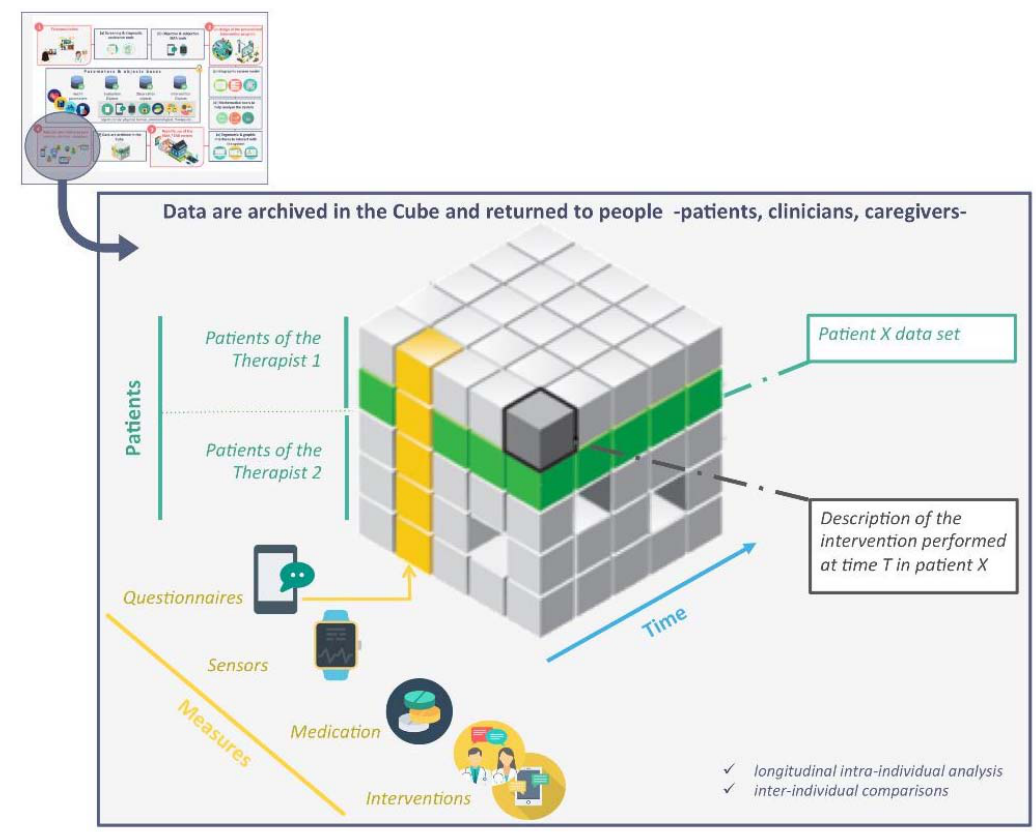
Figure 2. Patients X measures X time database.